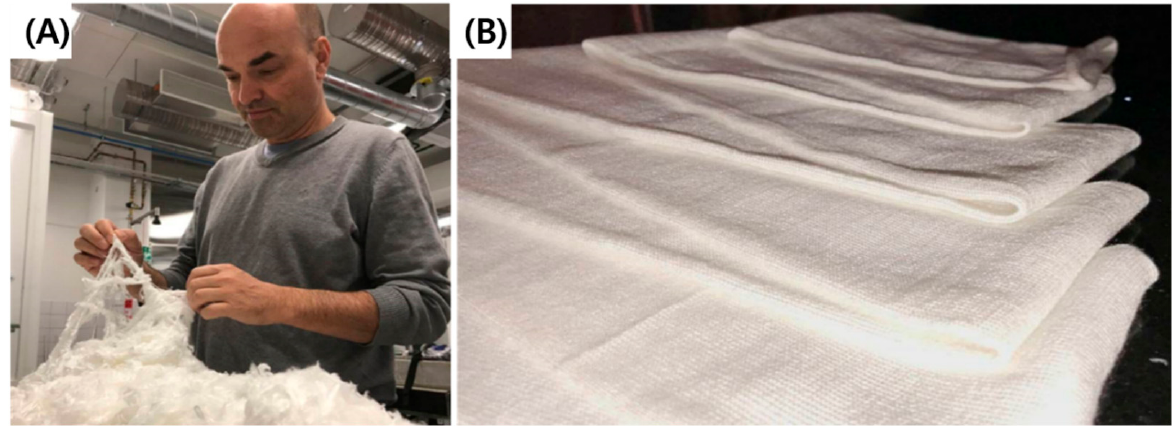
Figure 11. ( A ) Gary Cass, who is now one of the non-executive directors of Nanollose with the Nullarbor Fibre TM and ( B ) fabric made with microbial cellulose [186].